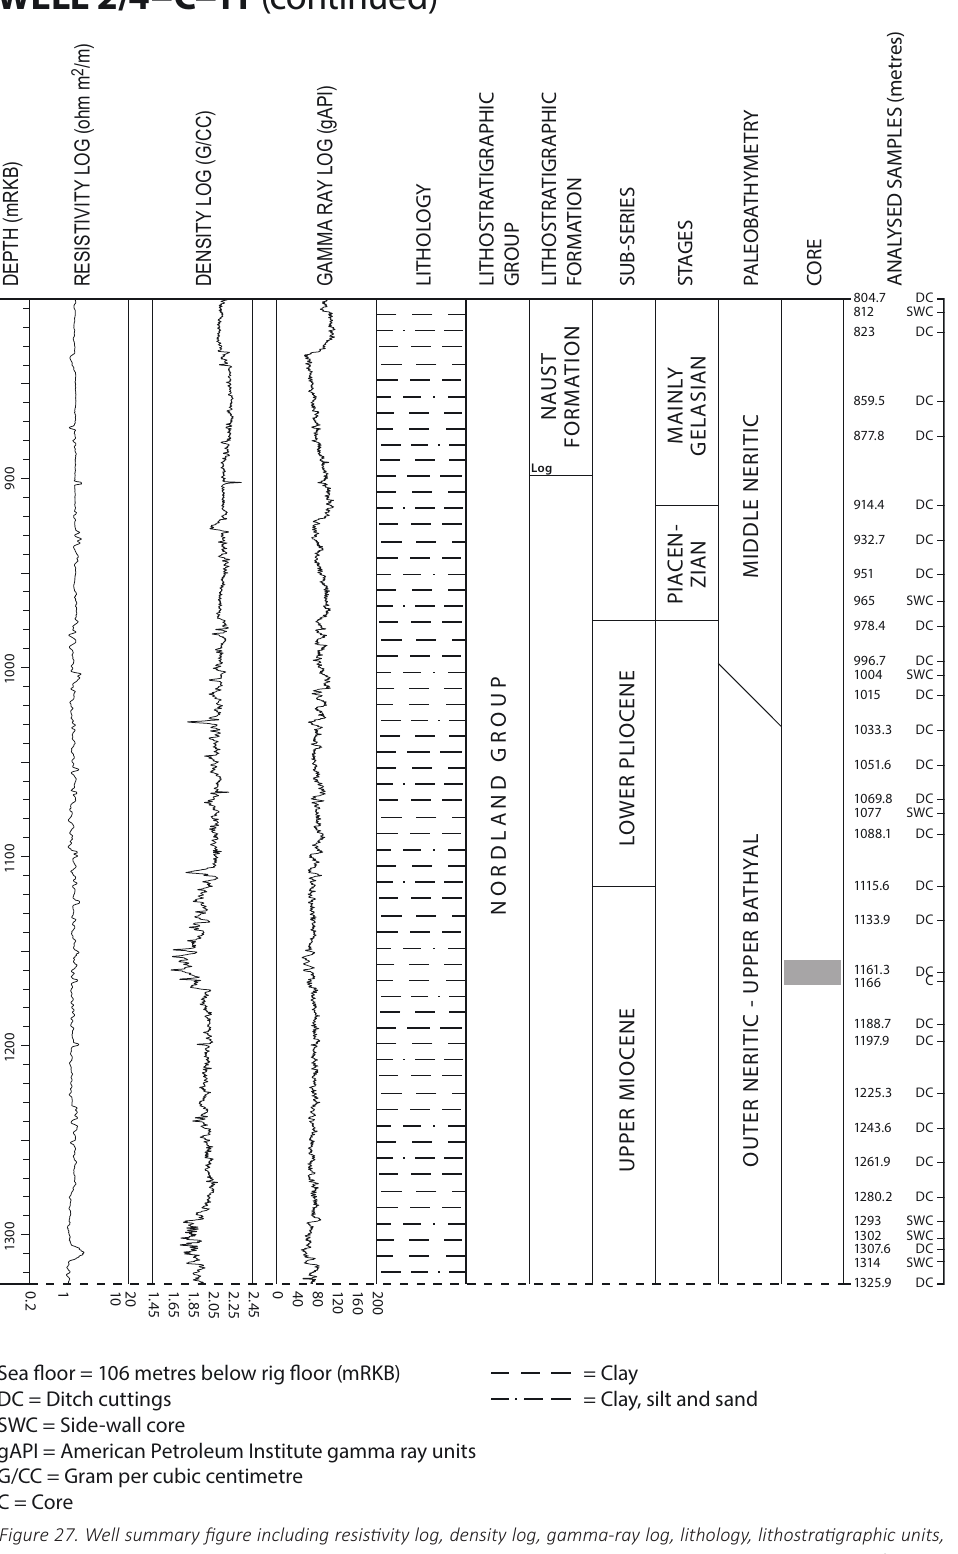
Figure 27. Well summary figure including resistivity log, density log, gamma-ray log, lithology, lithostratigraphic units, sub-series, paleobathymetry and analysed samples for the upper part of the investigated sequence in well 2/4–C–11 (upper Miocene (upper part) to Gelasian) (modified after Eidvin et al., 1999,